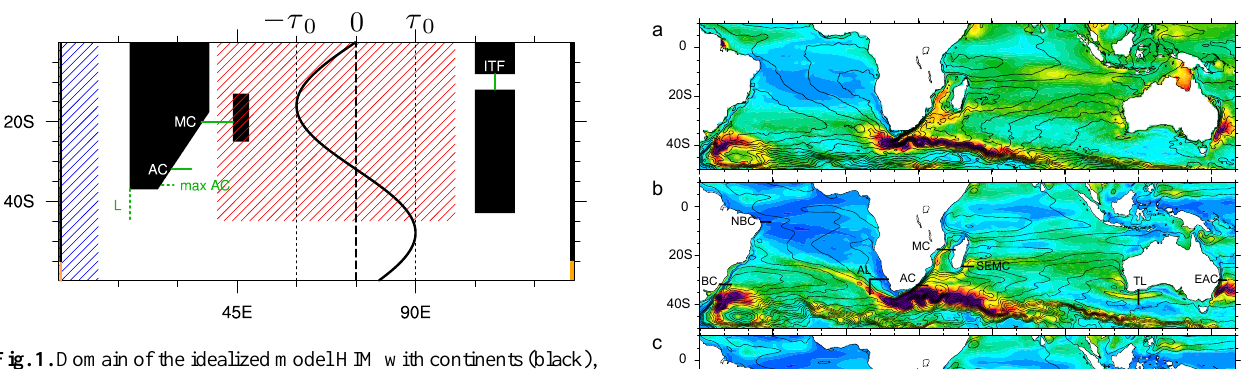
Fig. 1. Domain of the idealized model HIM with continents (black), ridge (orange), profile of wind stress forcing and important sec- tions (ITF: Indonesian Throughflow, MC: Mozambique Channel, AC: Agulhas Current, L: Leakage). Also indicated is the regions where tracer concentration is fixed to 1 (red hatching) and 0 (blue hatching). The passive tracer is used to compute the leakage, it is initialized to zero in the white regions but is free to evolve in time.